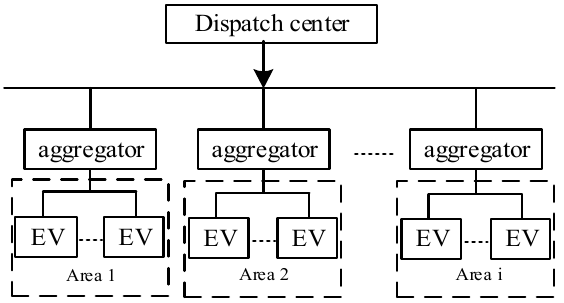
Figure 7. Distributed scheduling structure diagram.